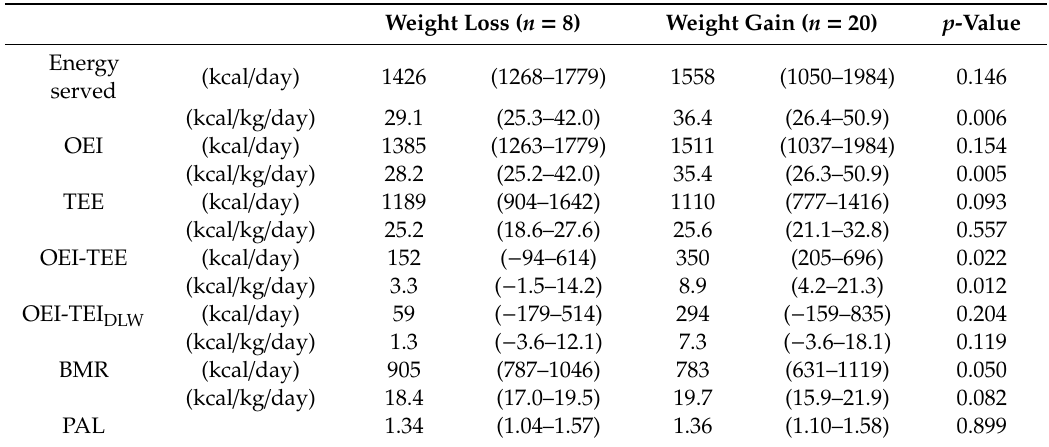
Table 3. Energy served, observed energy intake, energy expenditure, and physical activity level (analysis